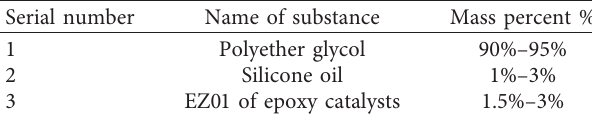
Table 3: Composition of combined